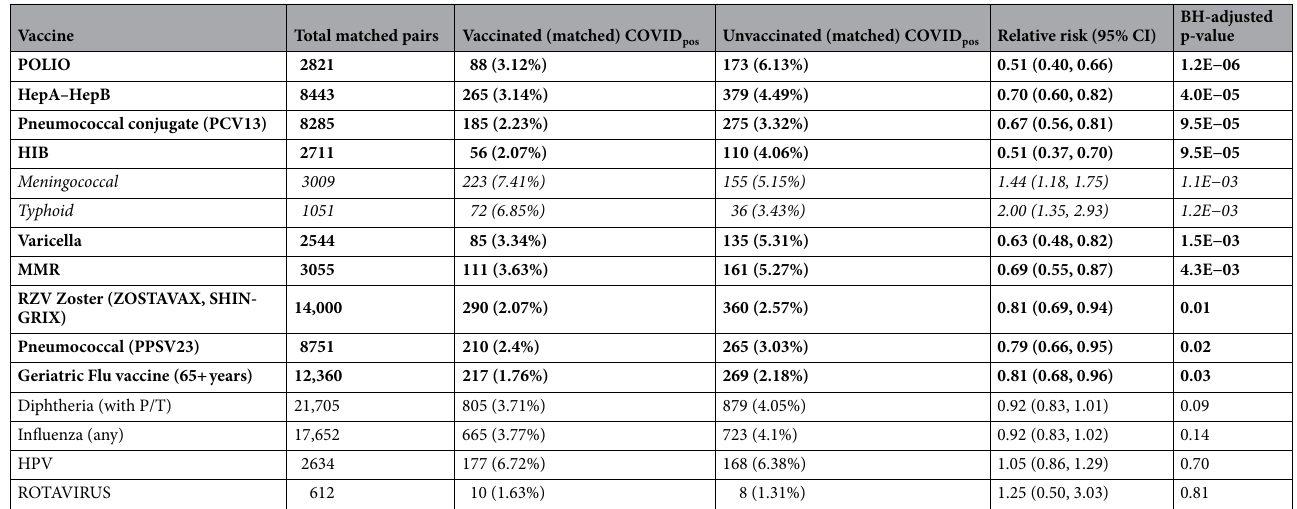
Table 5. Summary of SARS-CoV-2 rates for vaccinated and unvaccinated propensity score matched cohorts (2 year time horizon). Table of SARS-CoV-2 infection rates for vaccinated and unvaccinated (matched) cohorts for vaccines administered within 2 years prior to PCR testing. Rows in which the SARS-CoV-2 rate is lower (adjusted p-value < 0.05) in the vaccinated cohort are highlighted in bold, and rows in which the SARS-CoV-2 rate is lower in the unvaccinated cohort are highlighted in italic. The columns are (1) Vaccine: Name of the vaccine, (2) Total matched pairs: Number of pairs from the propensity matching procedure, which is the sample size of both vaccinated and unvaccinated cohorts after matching, (3) Vaccinated (matched) COVID pos : Number of COVID pos cases among the vaccinated (matched) cohort, along with the percentage in parentheses, (4) Unvaccinated (matched) COVID pos : Number of COVID pos cases among the unvaccinated (matched) cohort, along with the percentage in parentheses, (5) Relative risk (95% CI): Relative risk of COVID pos in the vaccinated (matched) cohort compared to the unvaccinated (matched) cohort, along with 95% confidence interval in parentheses, (6) BH-adjusted p-value: Benjamini–Hochberg-adjusted Fisher exact test